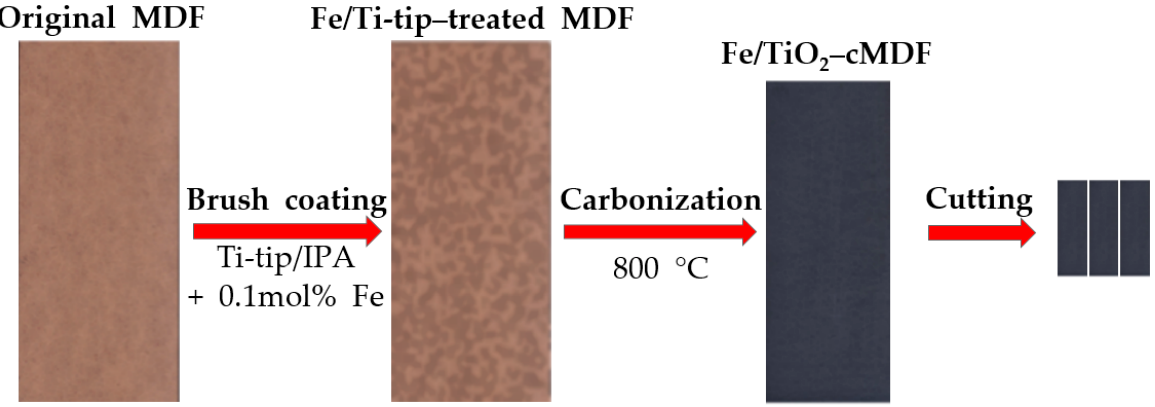
Figure 1. Preparation of the Fe/TiO 2 –cMDF panel and slabs.